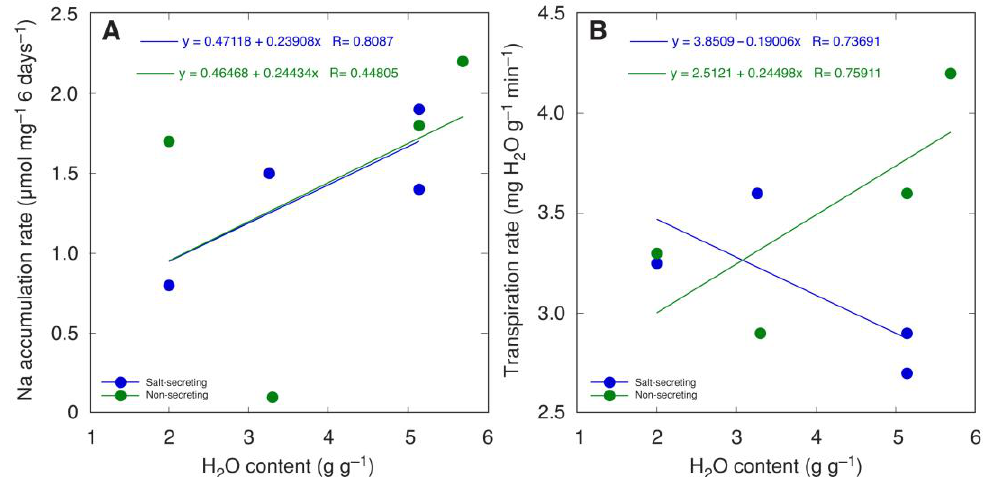
Figure 3. Relationship between shoot water content and Na + accumulation rate ( A ) and transpiration rate ( B ) for salt-secreting ( Glaux maritima, Armeria maritima, Limonium vulgare, Spartina anglica ) and non-salt-secreting ( Juncus maritimus, Juncus articulatus, Atriplex hastata, Atriplex littoralis ) halophyte species grown on 0.2 M NaCl. Data were taken from Rozema et al., 1981 [182] and recalculated. Species of the genus Beta have received special attention in salt tolerance studies due to relatively high salinity tolerance of both wild ancestors as well as cultivated crop forms.